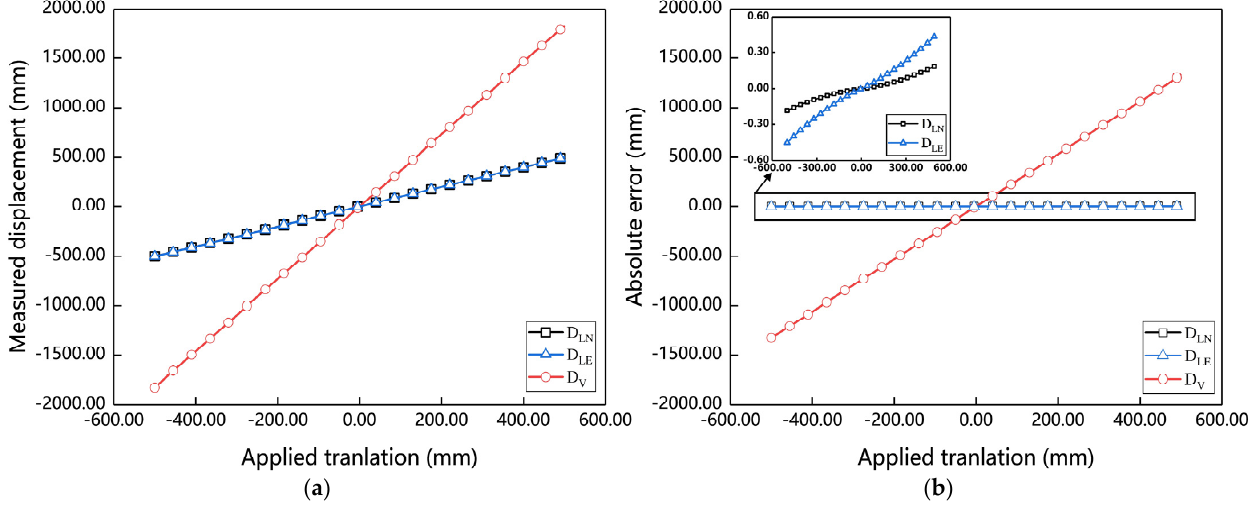
Figure 8. Measurement results of target point displacement in simulation experiment: ( a ) measured displacement; ( b ) absolute error.